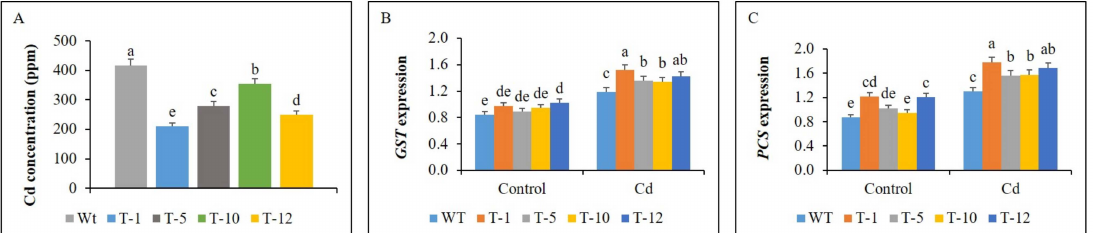
Figure 8. Comparison of Cd concentration ( A ) in WT and transgenic petunia cv. ‘Mirage Rose’ plants under cadmium (Cd) stress, and comparison of the expression levels of GST ( B ) and PCS ( C ) in their leaves under control and cadmium (Cd) stress conditions. Data represent the means of three replicates, and error bars indicate standard error. Means with the same letters are not significantly different by least significant difference test (LSDT, p <